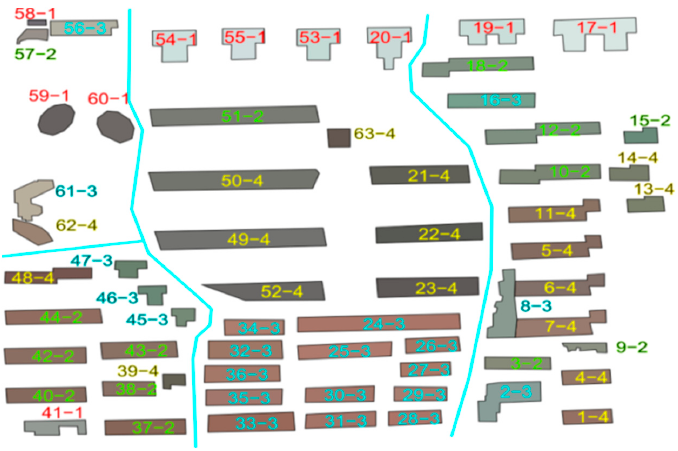
Figure 7. Texture classification by statistical analysis.